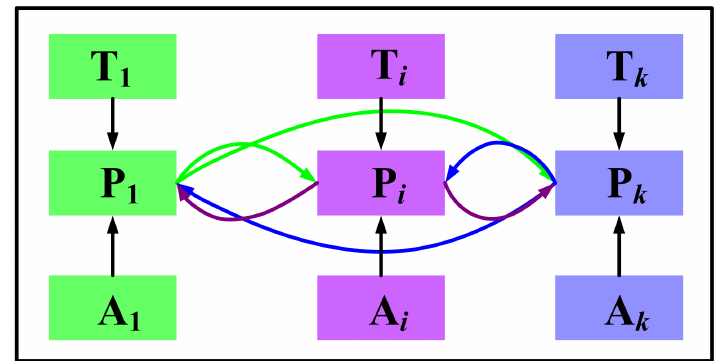
Figure 8. An illustration of the multi-population evolution framework (MPEF)